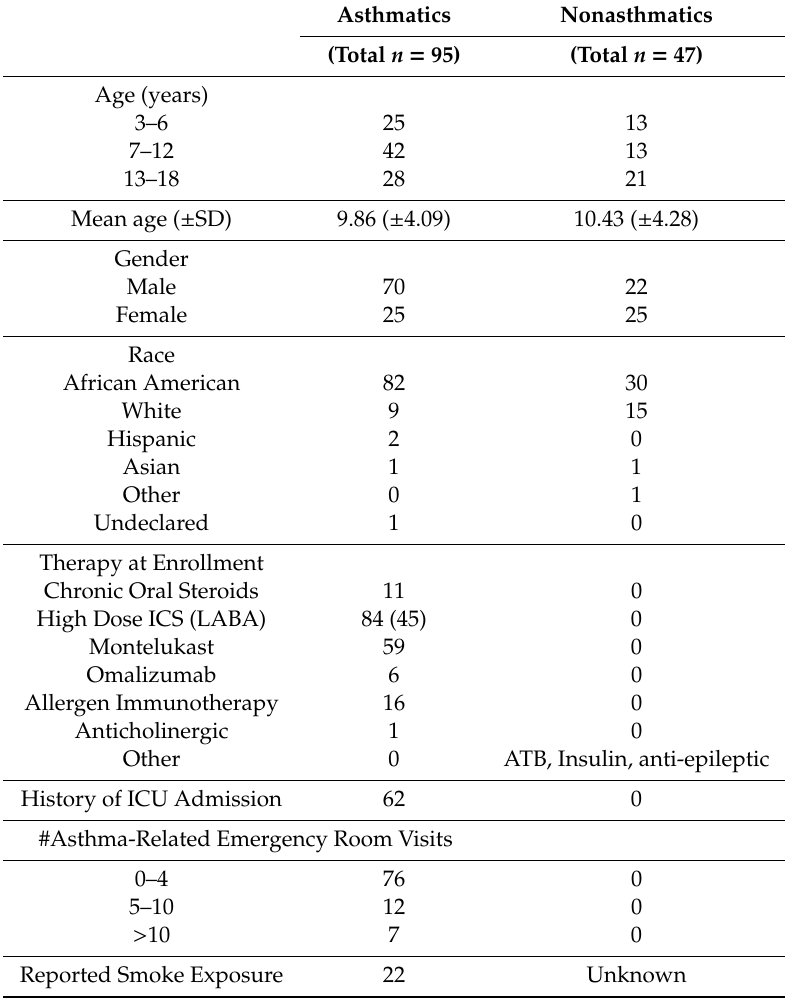
Table 1. Patient